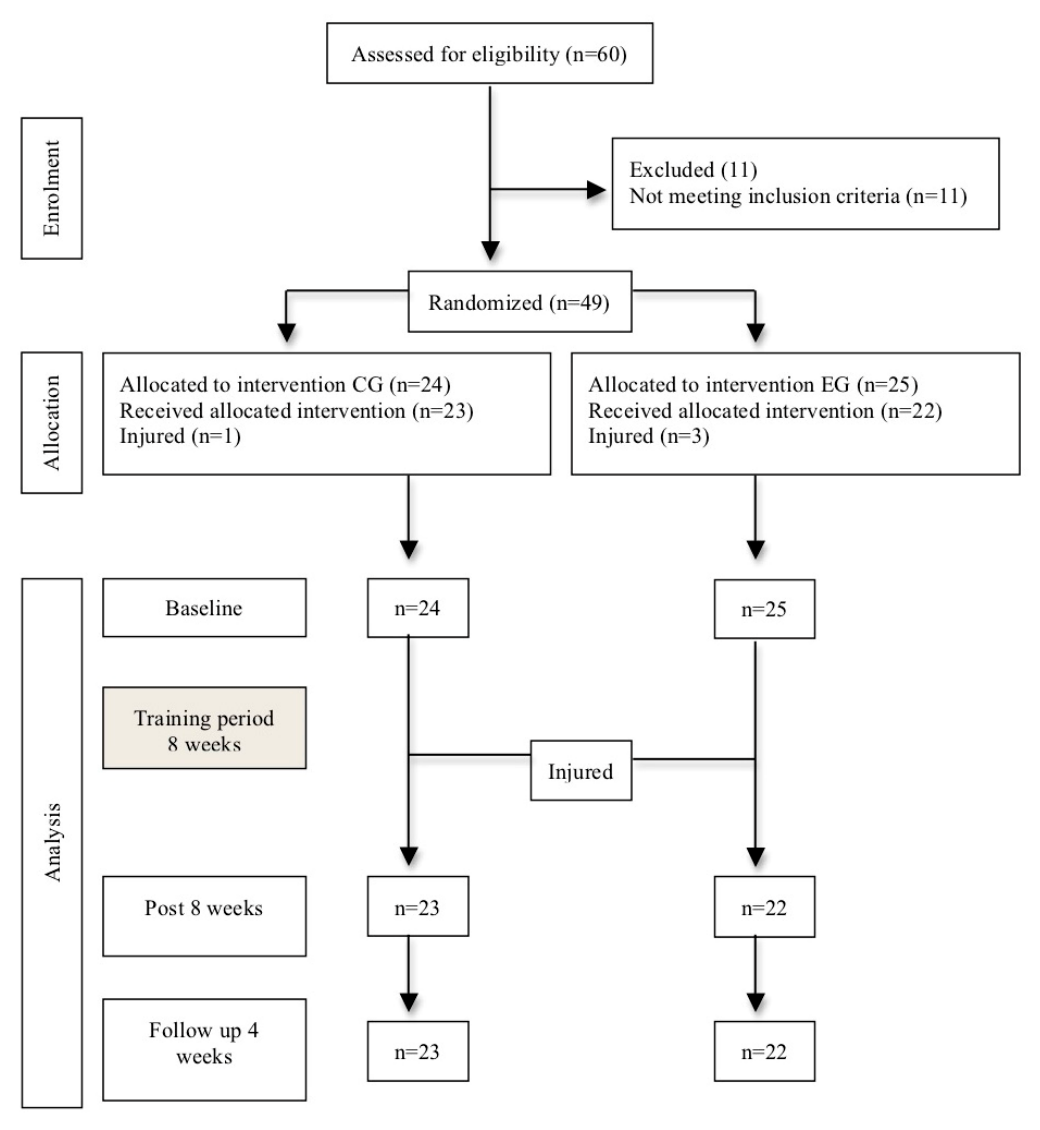
Figure 1. Consort diagram demonstrating participant flow through the study. Abbreviations: CG: control group; EG: experimental group.